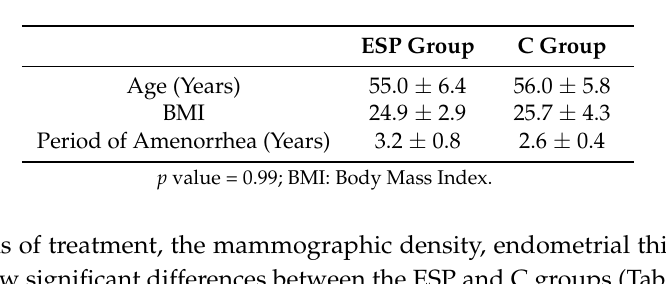
Table 1. Anamnestic and clinical features.